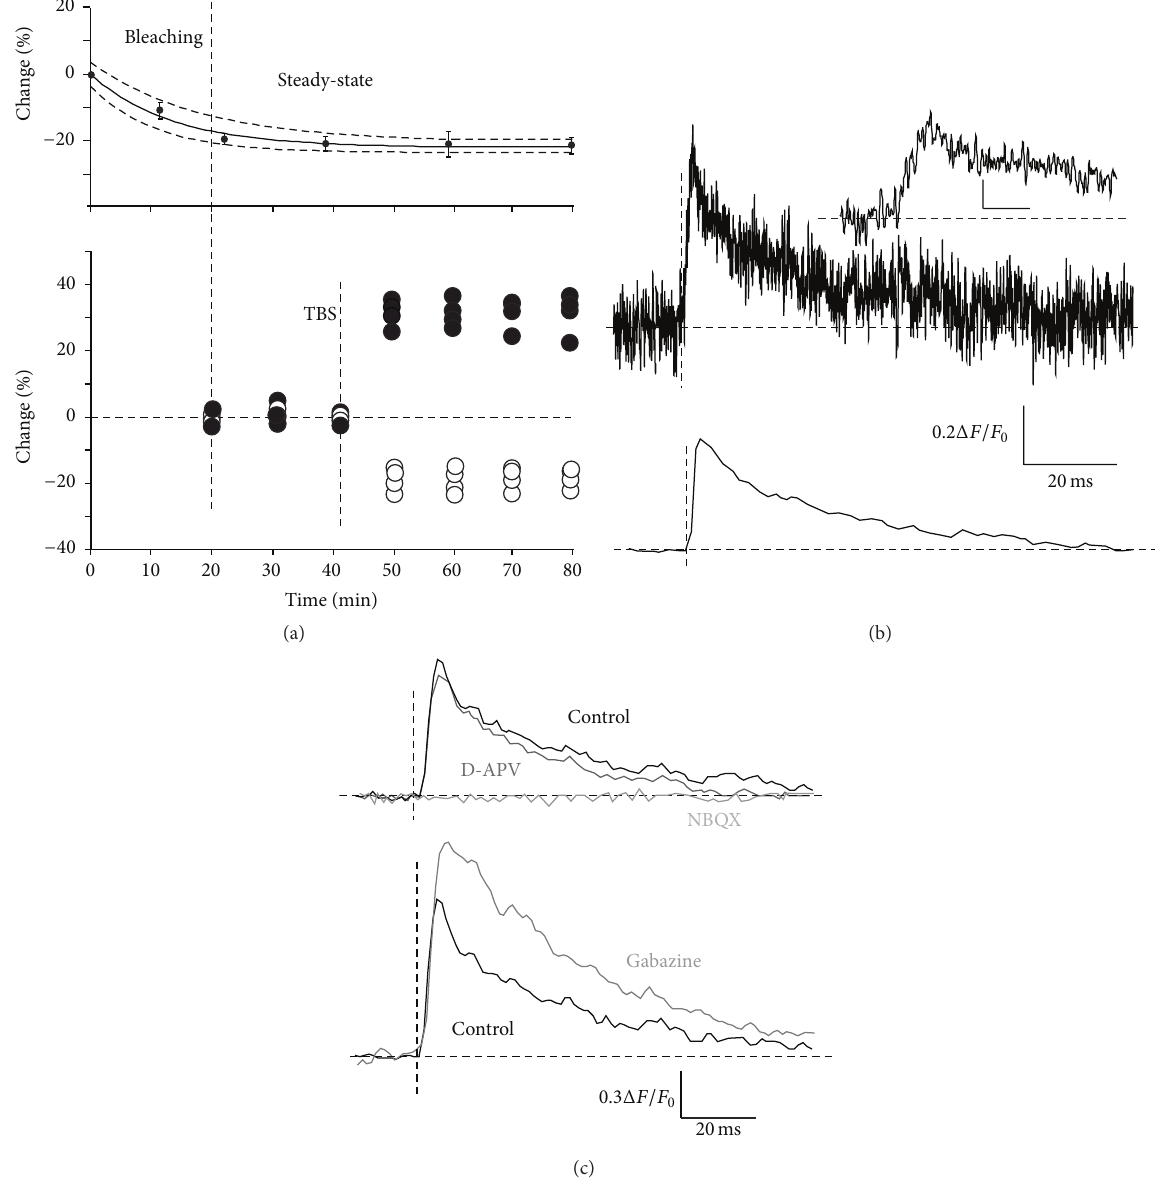
Figure 1: Properties of VSD imaging recordings. (a) Top . Time course of the peak amplitude of VSD signals averaged over five experiments in which TBS was not delivered. The signals tended to decrease exponentially in the first minutes of the acquisition to reach a steady-state level. The fitting function is represented over the experimental data, while dashed lines represent the fitting functions obtained by using the maximum deviations of the experimental data. Bottom . Time course of five regions of interest taken from a single experiment showing persistent positive or negative variations following TBS. Note that the control period used to calculate changes in VSD peak amplitude was taken in the steady-state region. (b) Top . VSD signal taken from granular layer and obtained in response to a single stimulus delivered to the mf. The trace was sampled at 2 kHz without averaging or filtering. The inset shows the initial phase of the VSD response (scale bar 10ms and 0.1 Δ𝐹/𝐹 0 ). Bottom . The trace shows the average of 10 repetitions sampled at 1kHZ. (c) Top . VSD signals obtained in control solution (black trace) and in response to the application of D-APV (dark gray) and NBQX (light gray). Bottom . VSD signals obtained in control solution (black) and in the presence of 10 𝜇 M